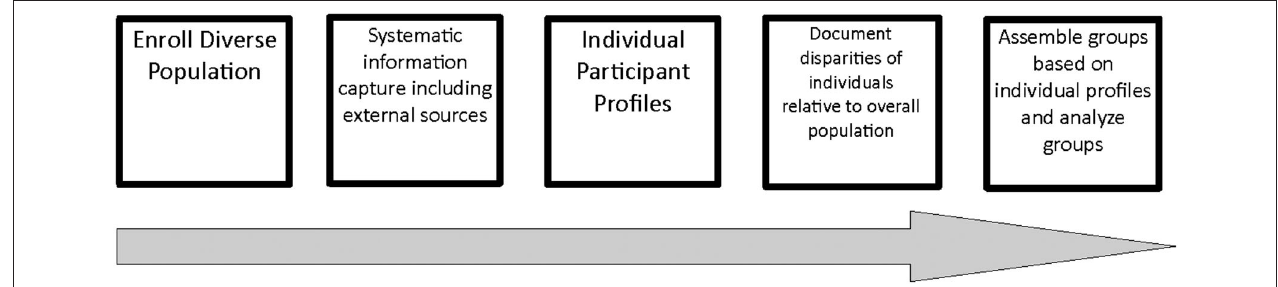
FIGURE 1 | Model for documenting health disparities based on enrolling for diversity. The work flow to enroll into a study a diverse population so that sufficient numbers of potentially vulnerable individuals are included. From a diverse study population, the opportunity to capture information, identify individuals, document disparities, and assemble and analyze groups